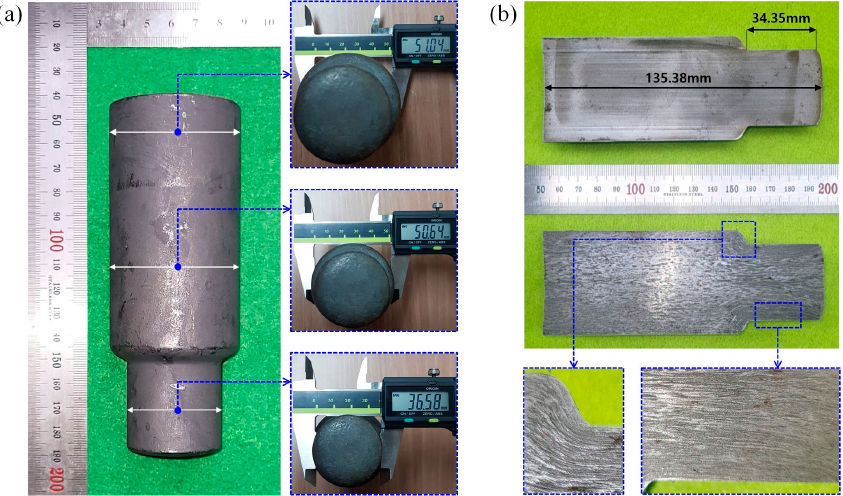
Figure 14. Fabricated preform and metal flow: ( a ) outer diameter of cold forward-extruded preform (unit: mm) and ( b ) metal flow on longitudinal cross-section.